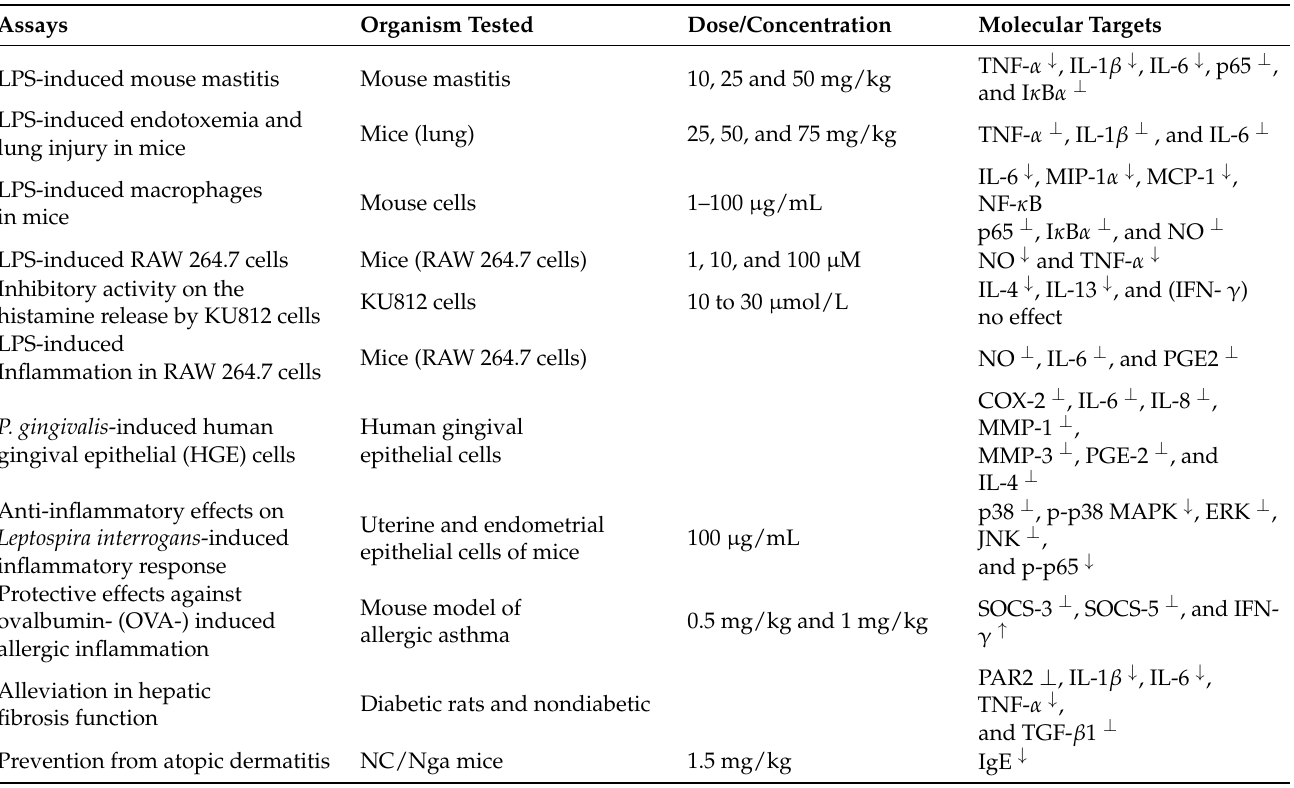
Anti-inflammatory activities of astragalin in vitro and in vivo, reproduced